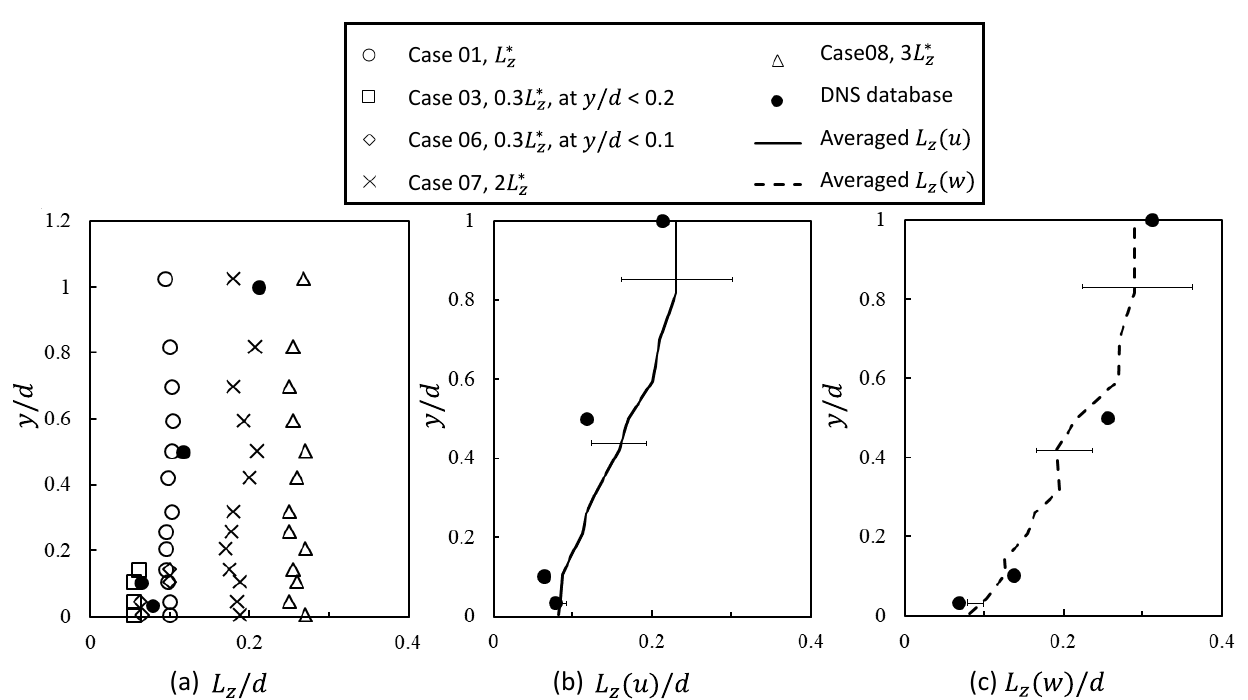
Figure 13. Lateral integral length scale distribution at the inlet and downstream sections. In the figure, ( a ) denotes all the lateral integral length scales at the inlet section ( ◦ : Case01, (cid:3) : Case03, (cid:5) : Case06, × : Case07, (cid:52) : Case08, • : DNS database), ( b ) the lateral integral length scale of streamwise velocity components at x/d = 50 ( • : DNS database, : Averaged L z ( u ) ), and ( c ) the lateral integral length scale of spanwise velocity components at x / d = 50 ( • : DNS database, : averaged L z ( w )